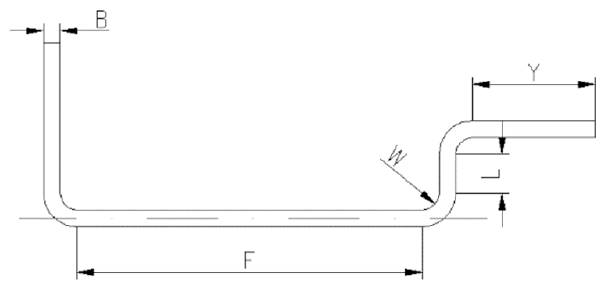
Figure 3. Cross-section of lower side beam of automobile. Table 3. Forming angle distribution of automobile lower beam.